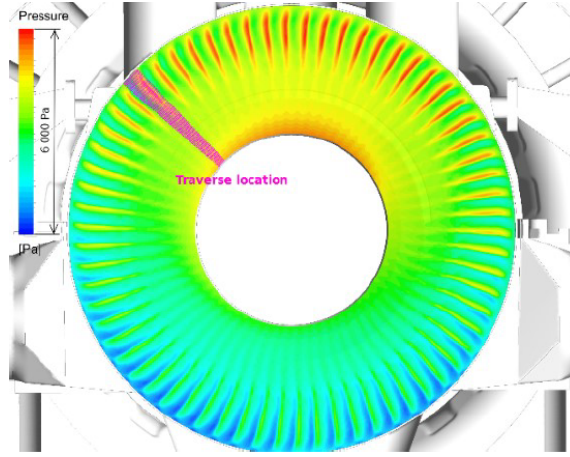
Figure 10. Static pressure flow field in Plane